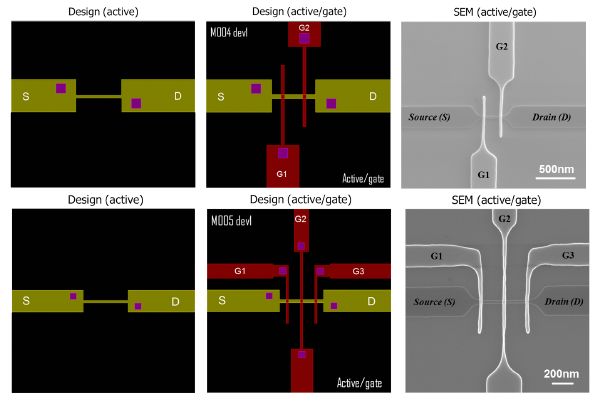
Figure 1. Two-gate and three-gate devices realized with deep-UV lithography. Left : mask design with the nanowire (yellow) and its Source (S) and Drain (D) extremities, and the two and three gates in red; Right : Scanning electron micrograph of actual devices, with a gate pitch of